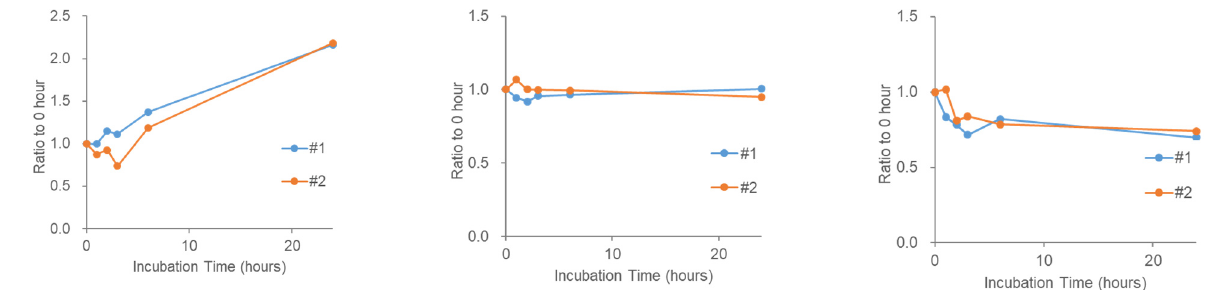
Figure 5. Stability of endogenous lysophospholipids and diacylglycerol in human serum during 37 °C incubation. Pooled serum was incubated for the indicated time and ( left ) lysophosphatidylcholine (LPC) 18:1, ( middle ) lysophosphatidylethanolamine (LPE) 18:1, and ( right ) diacylglycerol (DAG) 18:1/18:1 were analyzed using LC/MS after lipid extraction. The X -axis shows incubation time and values are shown on the y -axis relative to those at 0 h. Two replicate sample results are shown as lines.